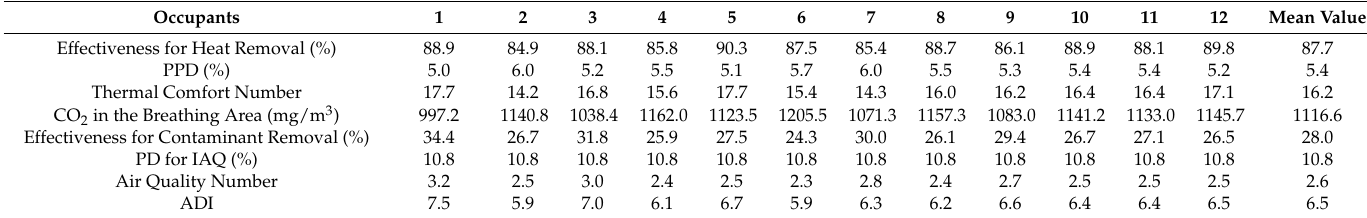
Table 4. ADI for an occupation of 12 persons, with an inlet air temperature of 20 ◦ C.